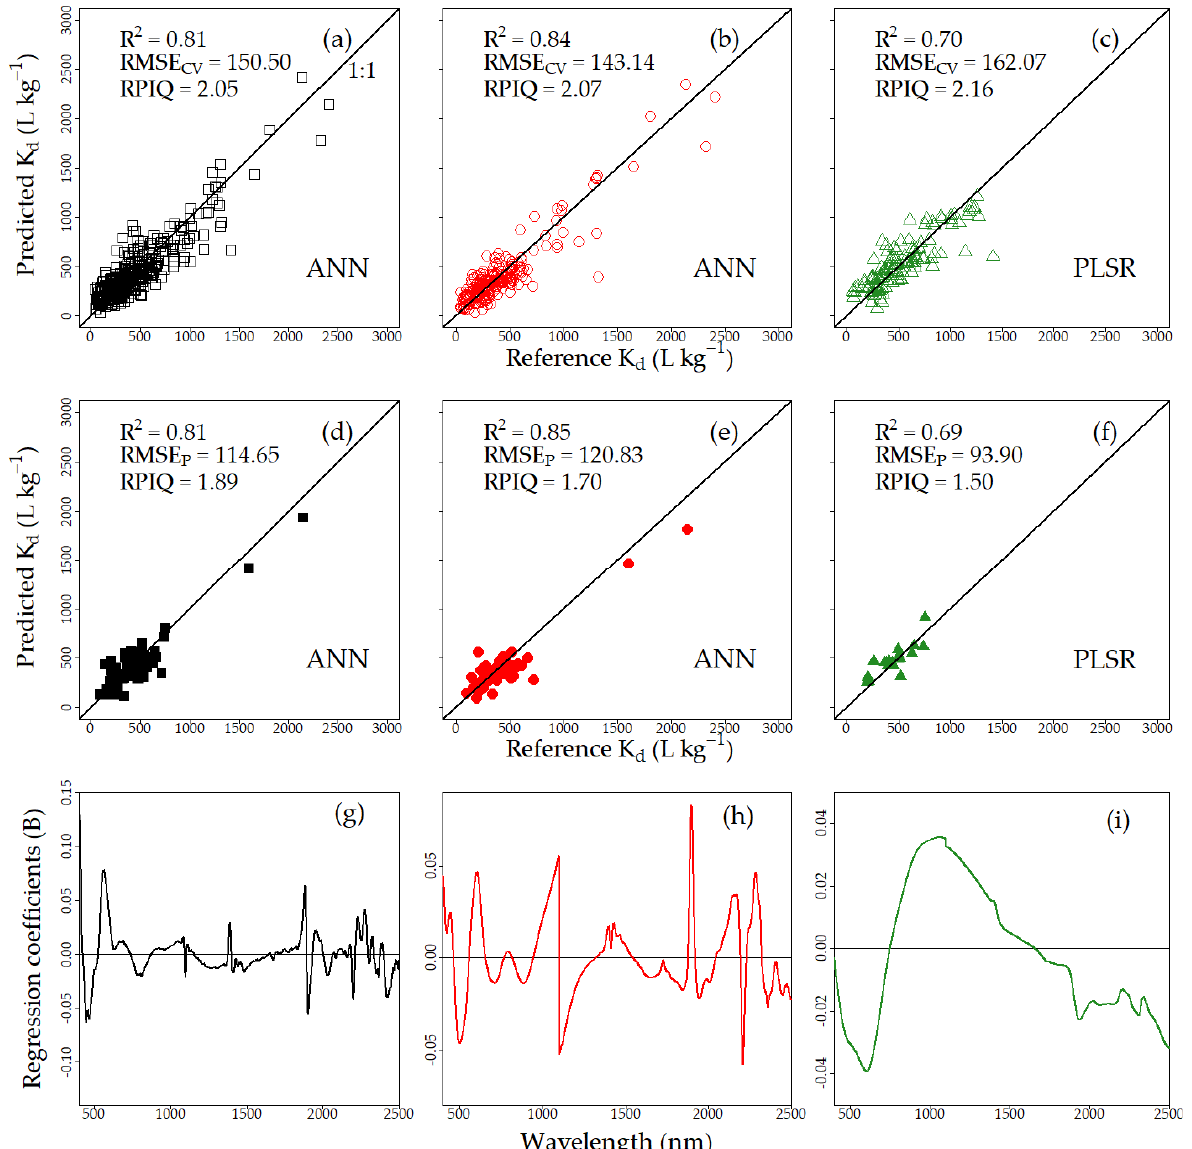
Figure 6. Results of the best vis–NIRS calibration and validation models with regression coefficients plot for combined ( a , d , g ), respectively), Danish ( b , e , h ), respectively), and Greenlandic ( c , f , i ), respec- tively) datasets. ANN, artificial neural network; PLSR, partial least square regression; R 2 , coefficient of determination; RMSE CV , root mean square error for cross-validation; RMSE P , root mean square error for prediction; RPIQ, ratio of performance to interquartile range.